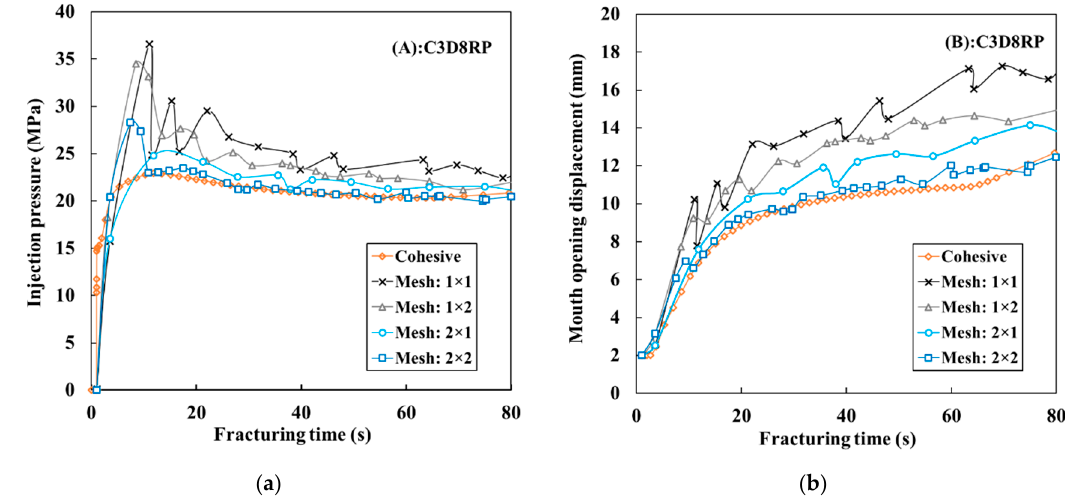
Figure 6. Variation of injection pressure and mouth opening displacement with C3D8RP: ( a ) Variation of injection pressure; ( b ) Variation of mouth opening displacement.